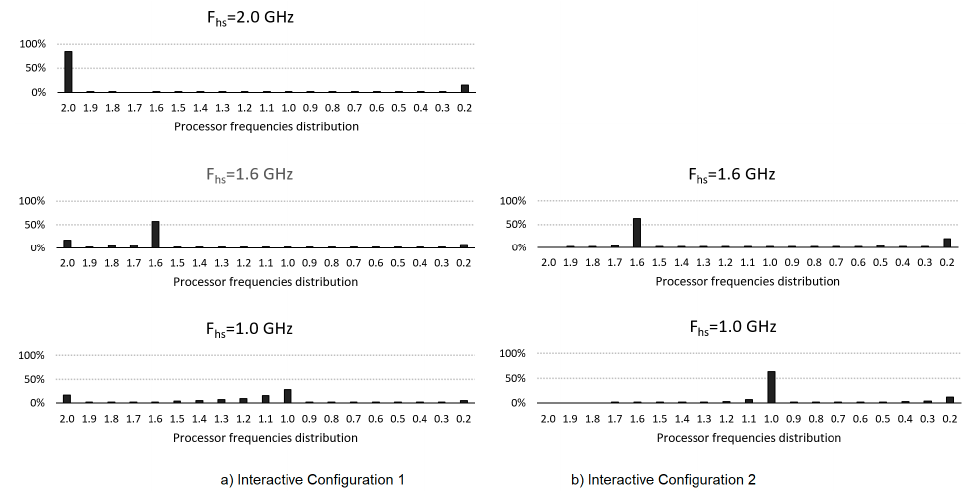
Figure 5. Core frequencies distribution for each configuration for Vid2 .